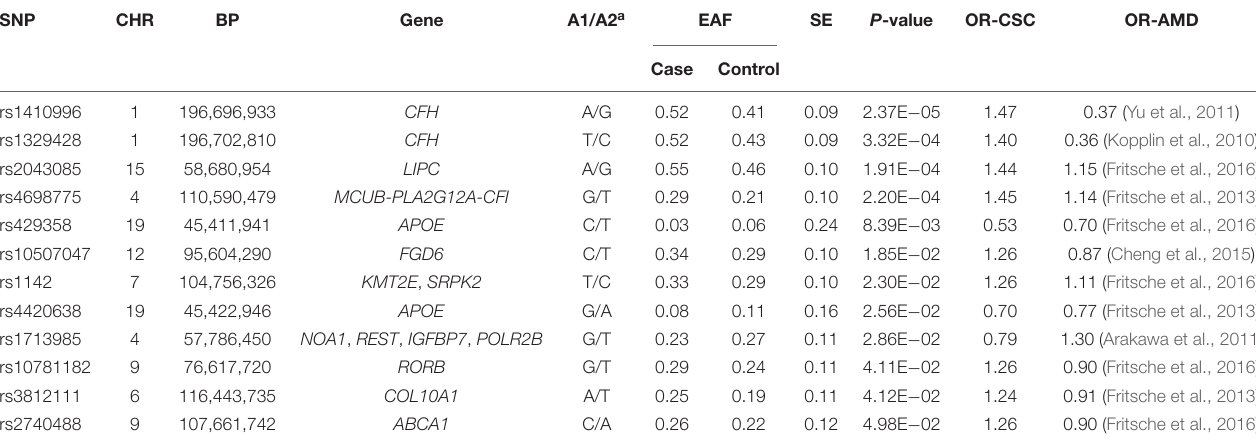
subunit beta; PLA2G12A, phospholipase A2 group XIIA; CFI, Complement factor I; APOE, apolipoprotein E; FGD6, FYVE, RhoGEF, and PH domain containing 6; KMT2E, lysine methyltransferase 2E; SRPK2, SRSF protein kinase 2; NOA1, nitric oxide associated 1; REST, RE1 silencing transcription factor; IGFBP7, insulin-like growth factor- binding protein 7; POLR2B, RNA polymerase II subunit B; RORB, RAR-related orphan receptor B; COL10A1, collagen type X alpha 1 chain; ABCA1, ATP-binding cassette subfamily A member 1. a A1/A2, effective allele and alternative